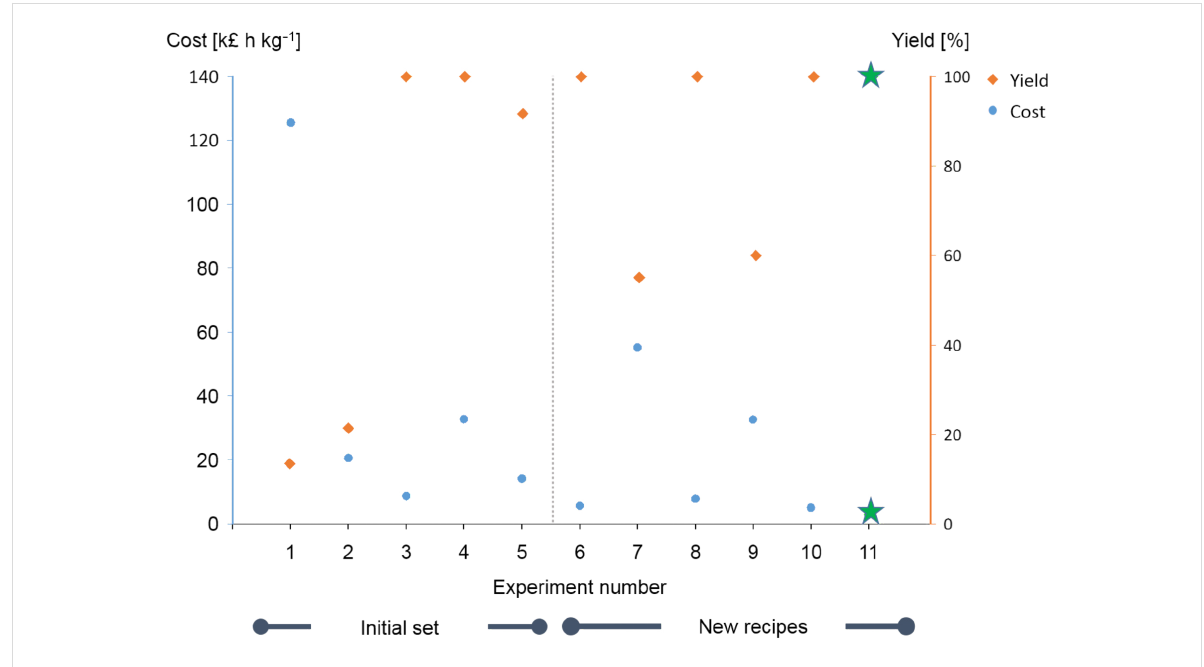
Figure 5: Results of the optimisation driven by a statistical algorithm and in the absence of a physical process model. Results of the training set and of sequential optimisation are shown. Information regarding the experimental conditions is given in Supporting Information File 1, Table S7.